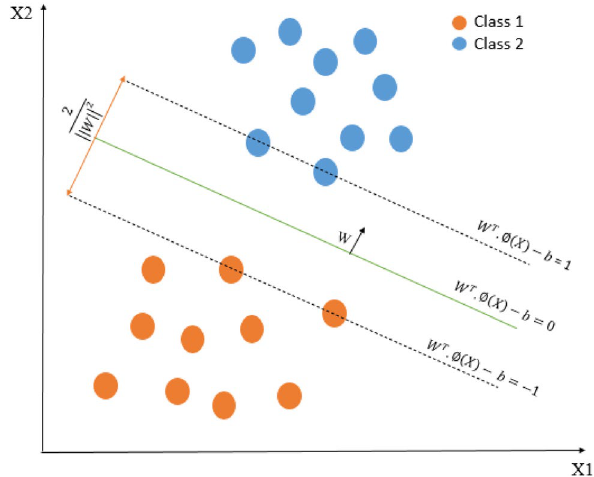
Fig. 3 Support vector machine